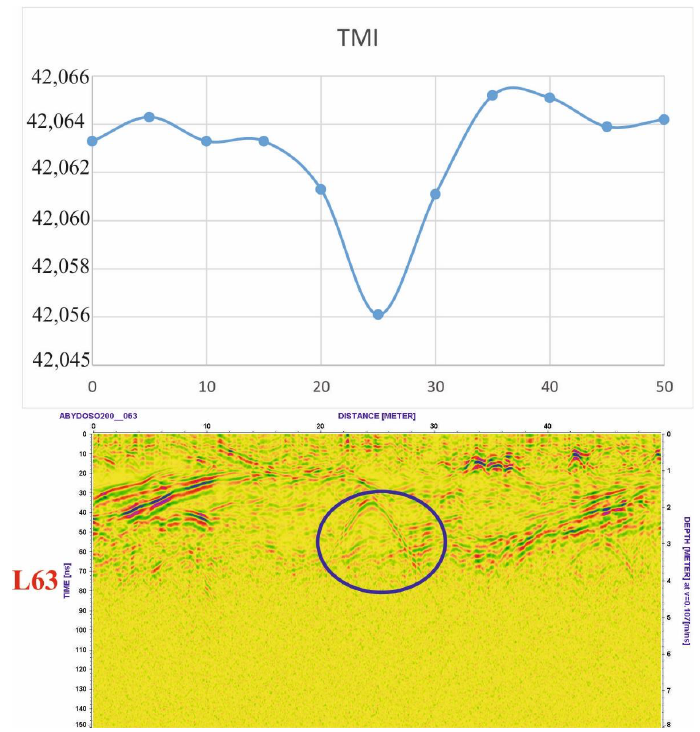
Figure 10. A correlation between magnetic and GPR findings for the same profile. The apex of the anomaly is located between 20 to 30 m from the beginning of the magnetic and GPR 2D cross section with the same width. The blue circle displays the anomalous feature, which is indicated by the hyperbolic shape and might be an ancient artefact.